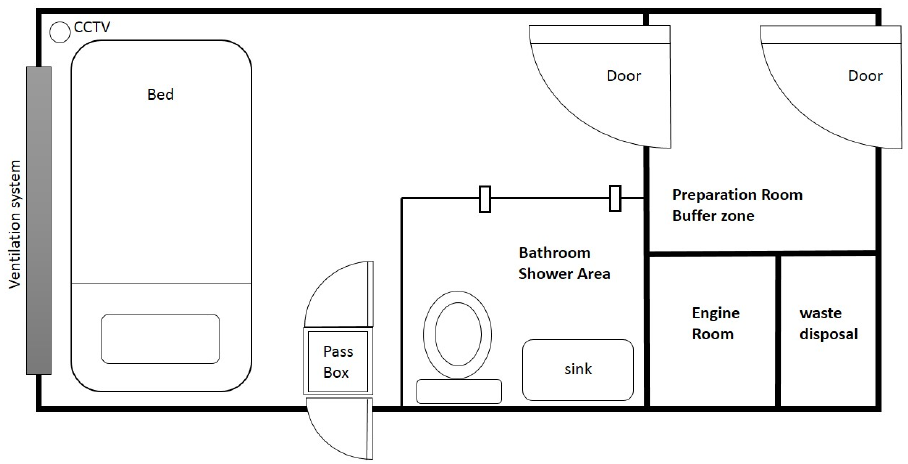
Figure 3. Layout of the negative pressure isolation ward.